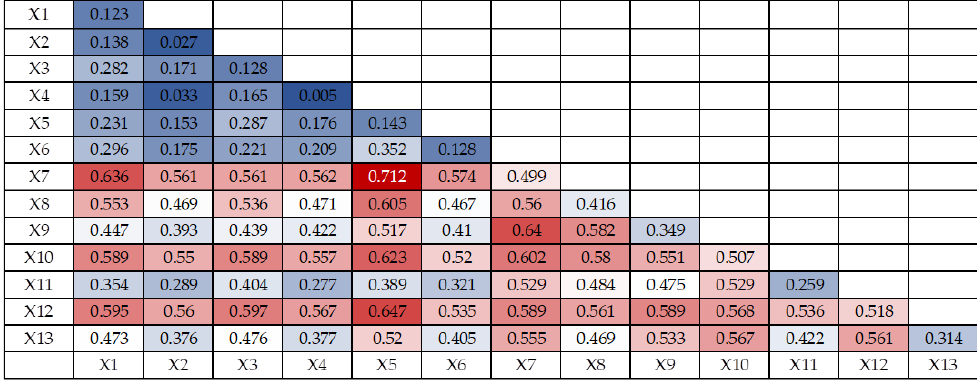
Figure 8. Ecological Vulnerability Interaction Detector Results in Shenyang in 2020.